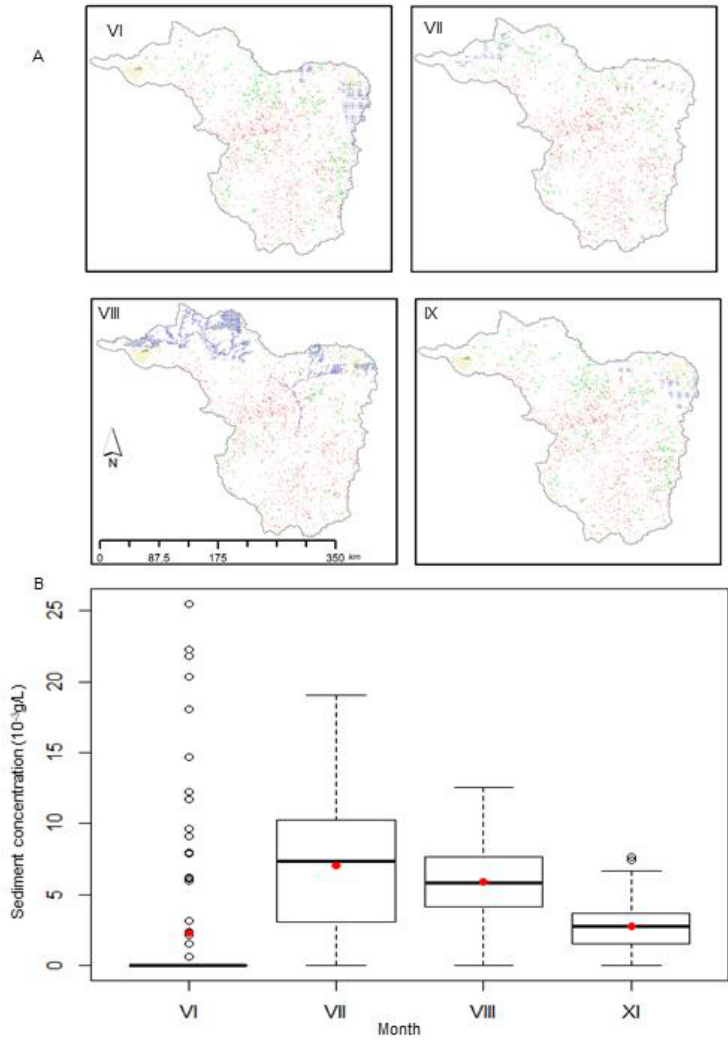
Figure 8. Comparison of hotspot mapping outputs with short-term measured sediment data in Setit catchment (Upper Atbara, Sudan): VI, June; VII, July; VIII, August; and IX, September. ( A ) Hotspots of soil erodibility (brown), connectivity (red), and monthly rainfall depth in respective month (blue) [53] are plotted. Green indicates vegetation hotspots at the beginning of the month, which were occurring each year between 2014 and 2016. ( B ) Boxplot of sediment concentration (10 −3 g/L) measured at catchment outlet in the respective month (2014–2016). First quartiles, medians, and third quartiles are plotted, while whiskers represent 1.5 × interquartile range. Inter-annual means are plotted as red dots.